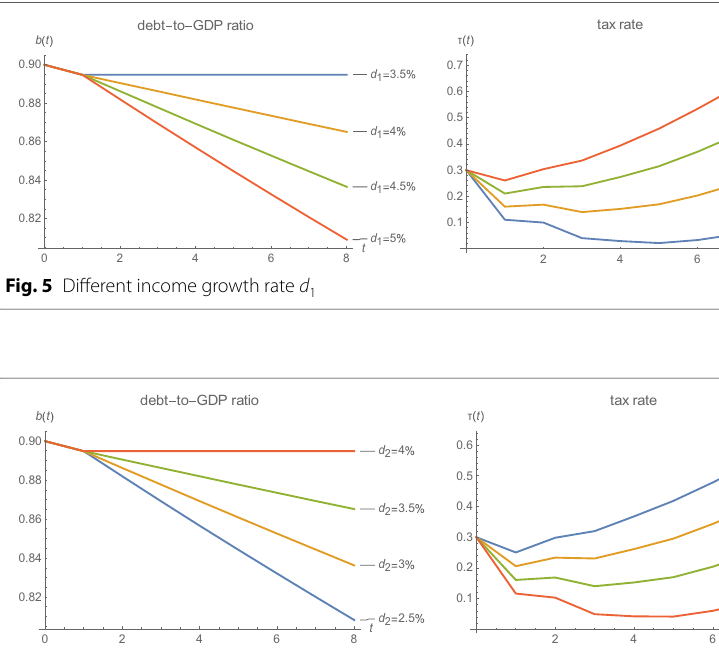
Fig. 6 Different debt growth rate d 2